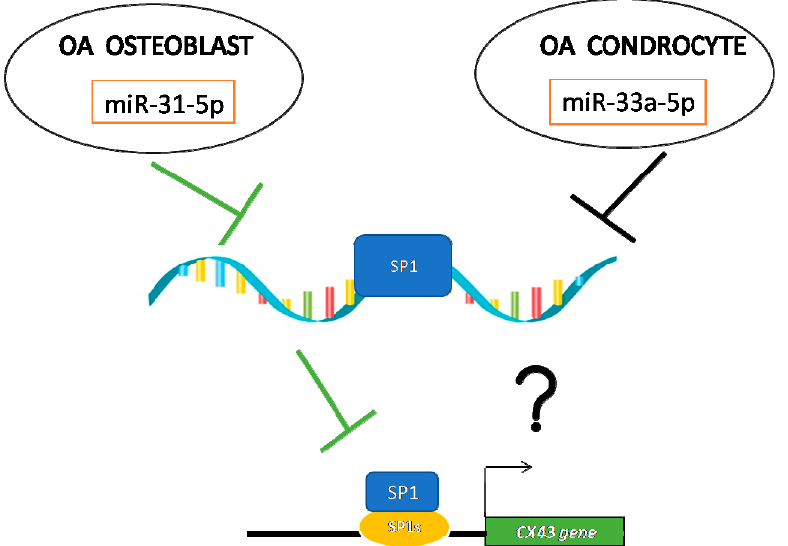
Figure 7. Our hypothesis of the molecular mechanism of miR-31-5p and miR-33a-5p on SP1/CX43 regulations in OA condition.